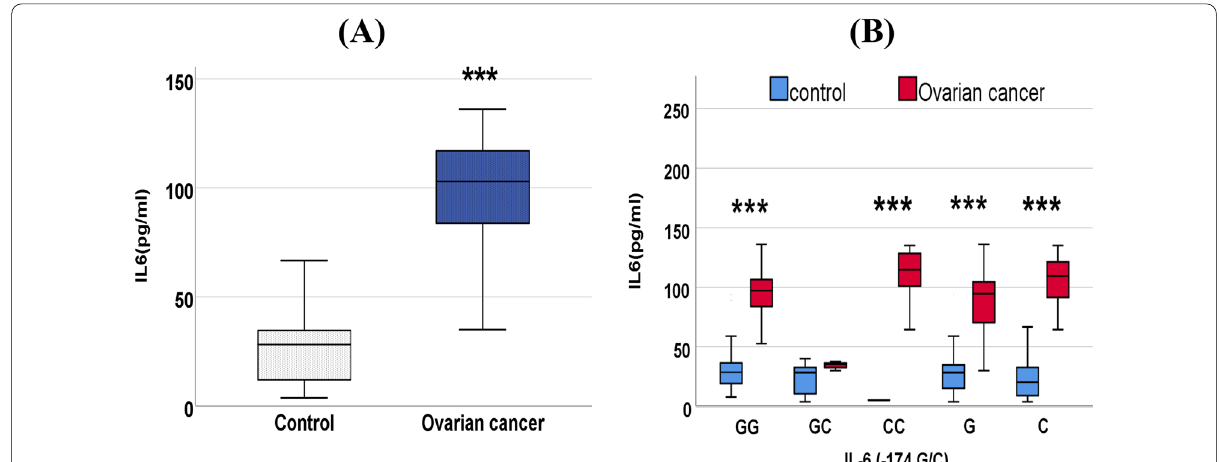
174 G/C) polymorphism in control and −